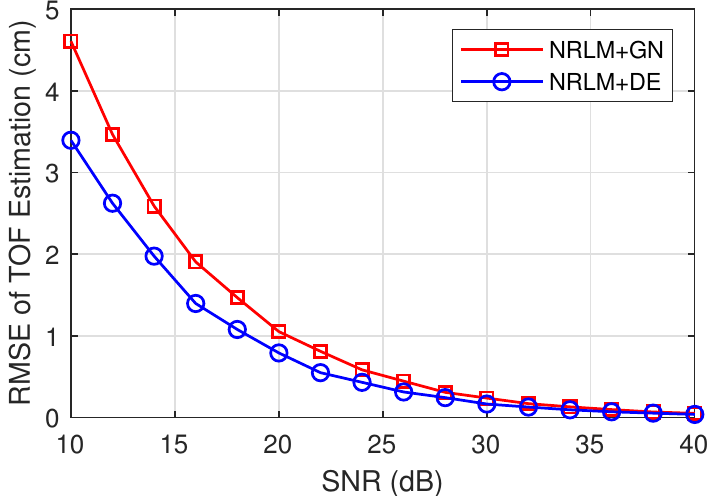
Figure 7. Simulation results of the TOF estimation with different